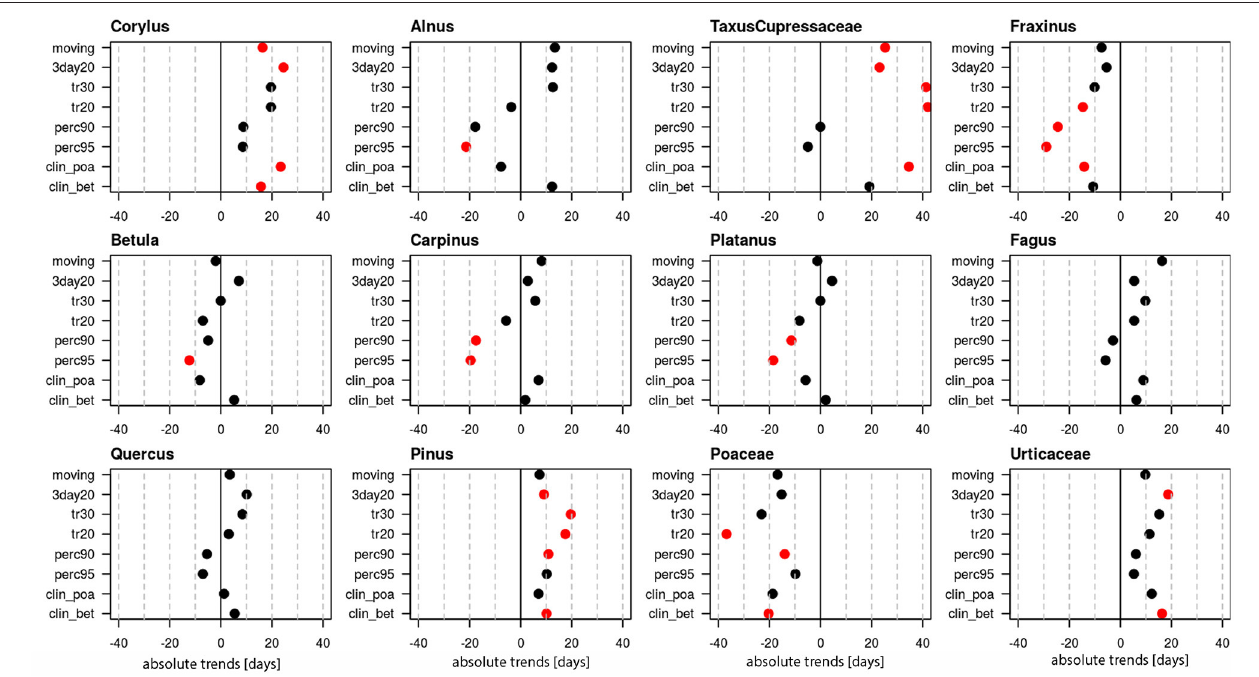
FIGURE 5 | Absolute trends [days] for the 50-year period 1969–2018 of the duration of the pollen season with eight different pollen season definitions. Red points show significant trends ( p -value ≤ 0.05), black points show non-significant trends.